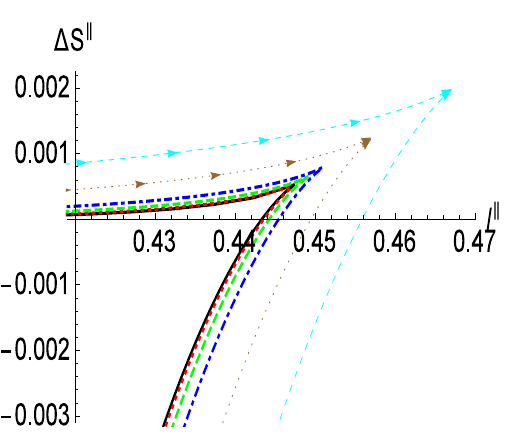
Figure 5 . (cid:1) S k as a function of ‘ k for various B , with ‘ c = 1. Here c = 2 and (solid, black), (dot, red), (dash, green), (dot-dash, blue), (arrow- dot, brown) and (arrow-dash, cyan) curves cor- respond to B = 0, 0 : 1, 0 : 2, 0 : 3, 0 : 5 and 0 : 7 respectively. In units GeV.